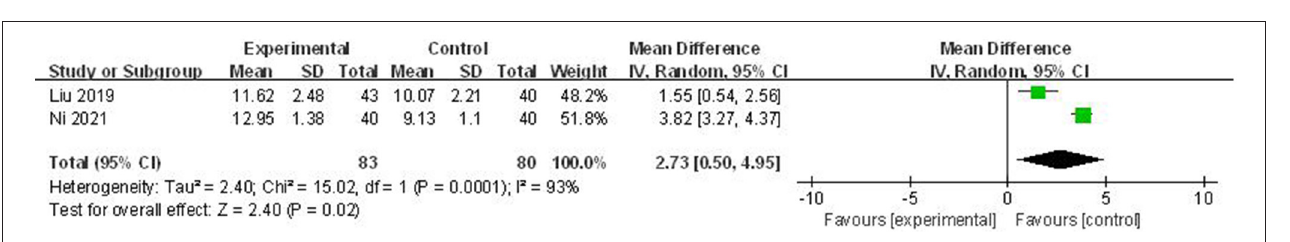
FIGURE 7 | Forest plots of acupuncture plus standard treatment vs. standard treatment: analgesic